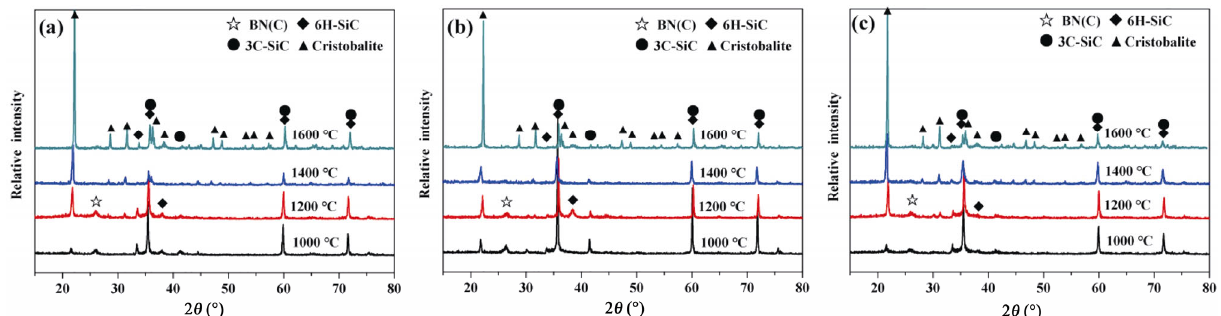
Fig. 10 XRD patterns of Si 2 BC 3 N ceramics after oxidation: (a) T0, (b) T1, and (c) T3.